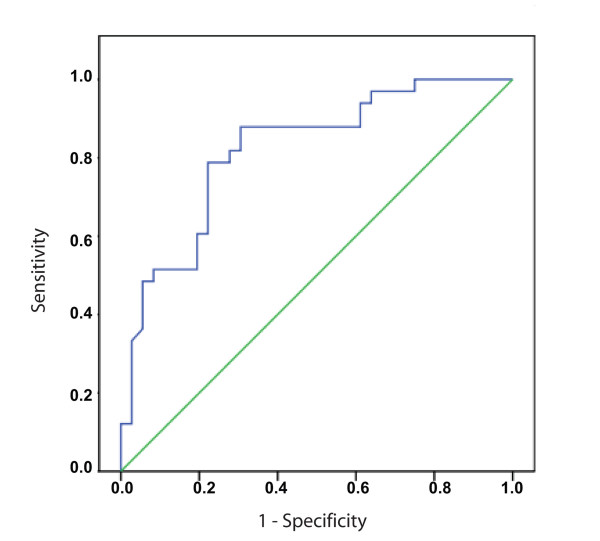
Utility of plasma connective tissue growth factor as a predictor of reduced right ventricular function. Receiver operating characteristic (ROC) curve depicting the ability of plasma connective tissue growth factor (CCN2) levels to predict the presence of reduced right ventricular (RV) function (AUC 0.82 [95% CI 0.72;0.92], p < 0.001). Plasma CCN2 levels ≥ 77 μg/L had 88% sensitivity and 69% specificity for detecting patients with reduced RV function.